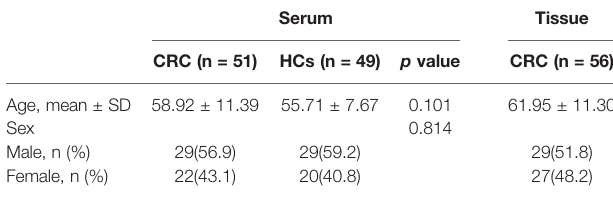
TABLE 1 | The baseline of the subjects.